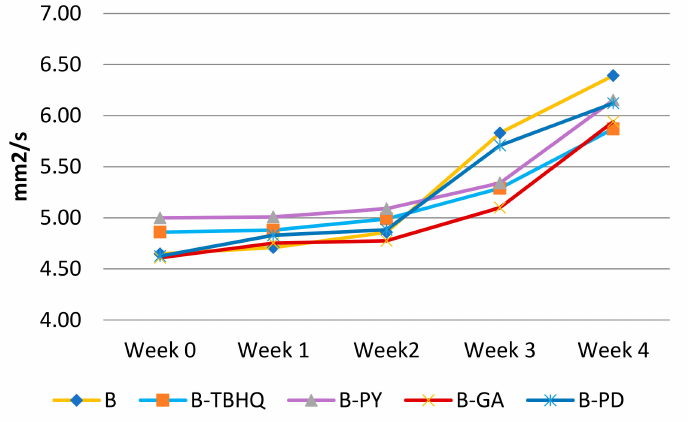
Figure 15. Viscosity vs. biodiesel